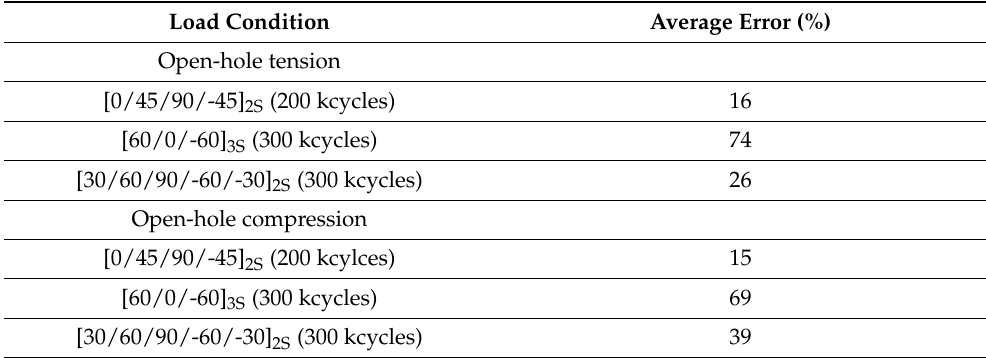
Table 1. Average errors in blind predictions of residual strength after fatigue loading of the seven models benchmarked in Reference